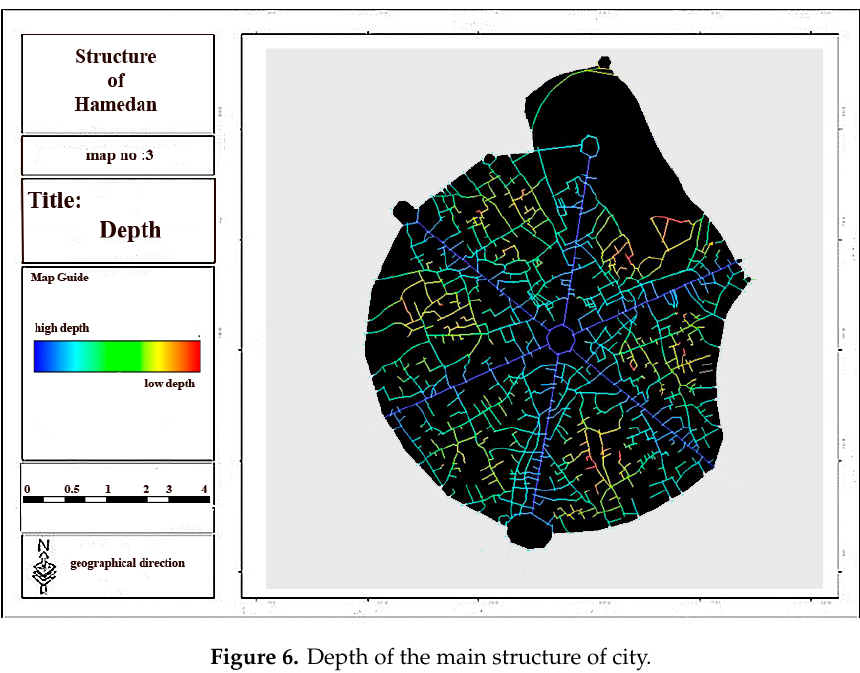
Figure 6. Depth of the main structure of city.